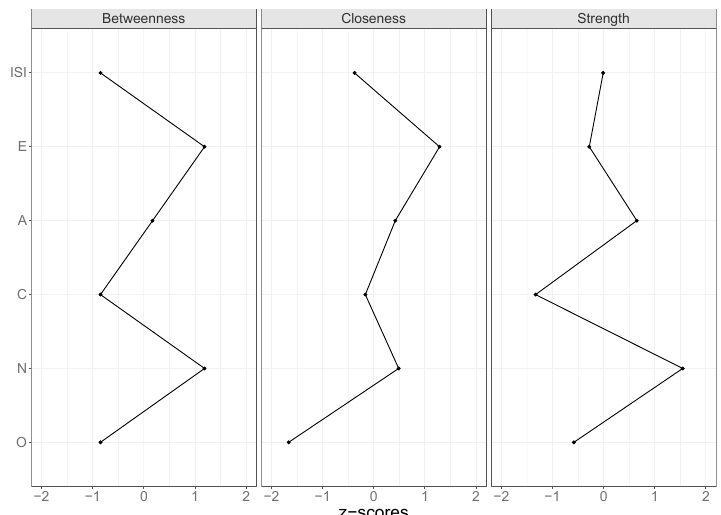
Figure 2. Standardized scores on the centrality measures of personality traits and the Insomnia Severity Index (ISI) sum score. Abbreviations: A = agreeableness, C = conscientiousness, E = extraversion, N = neuroticism, O = openness. The plots show that the personality traits neuroticism and extraversion are highest on all three centrality measures. Extraversion lies on the shortest path between two other nodes most often ( Betweenness ) and has the smallest overall distance to all other nodes ( Closeness ), while neuroticism is connected the strongest to its direct neighbors ( Strength ).